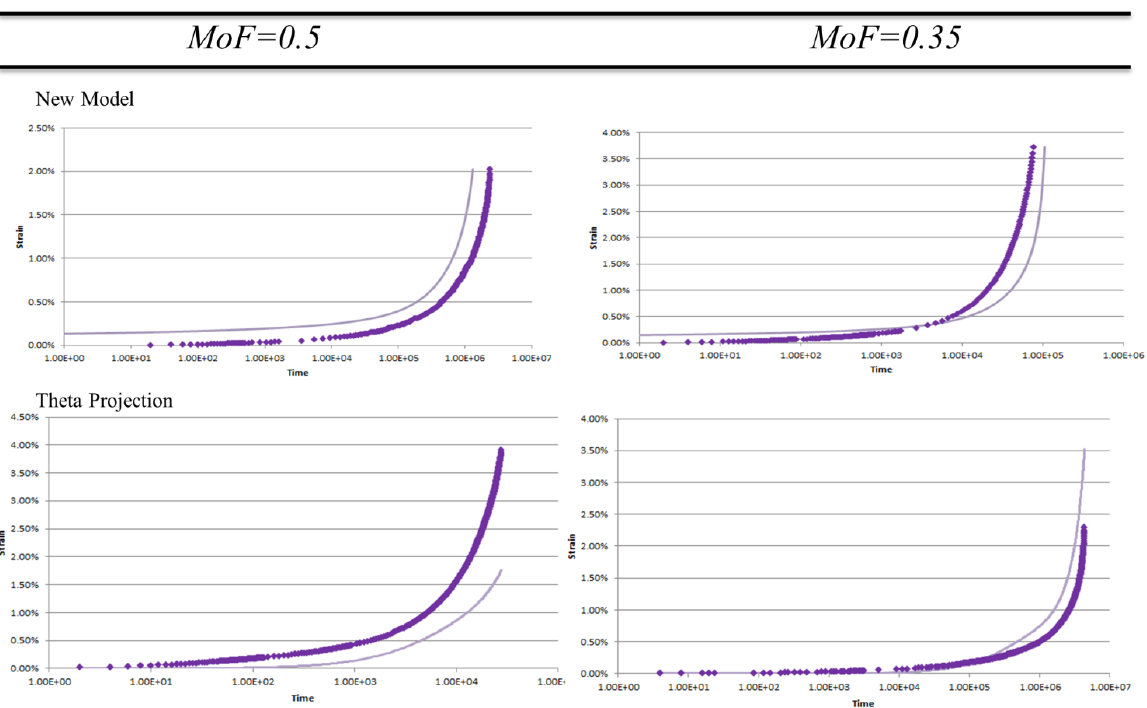
Figure 1. Examples of Measure of Fit Values for New Model and Theta Projection on linear scale. Experimental data ( ♦ ) model prediction ( ▬ ).